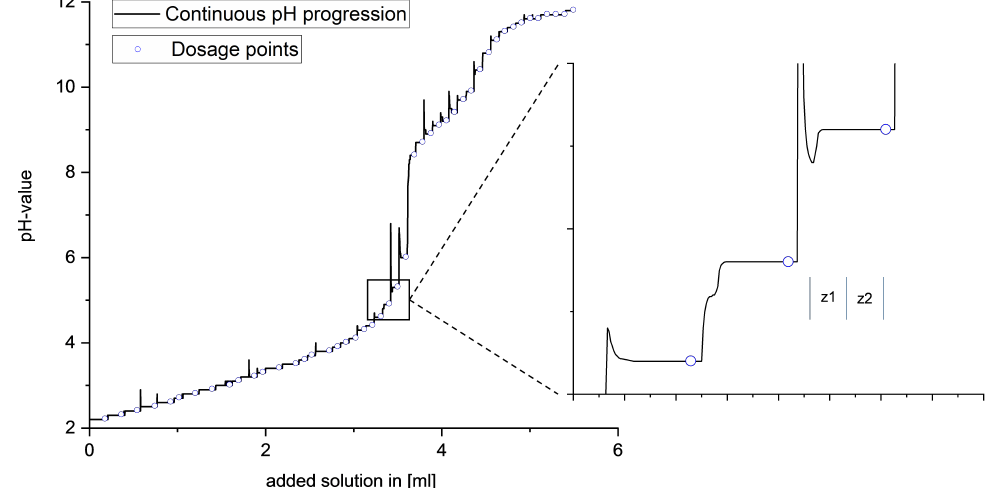
Figure 2. Example of a titration curve and detailed representation of the pH curve with time units and corresponding base dosing